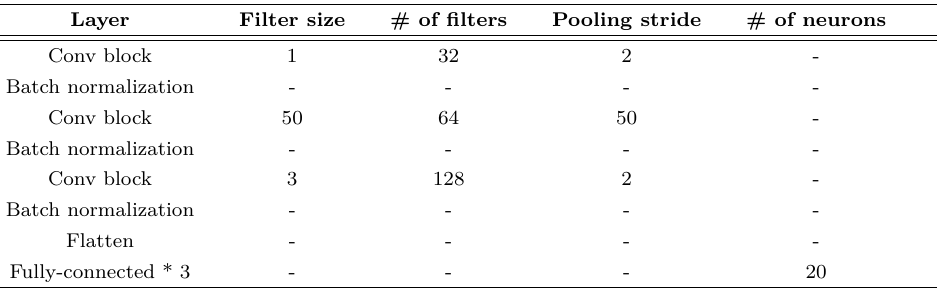
Table 6: CNN architecture of the ASCAD